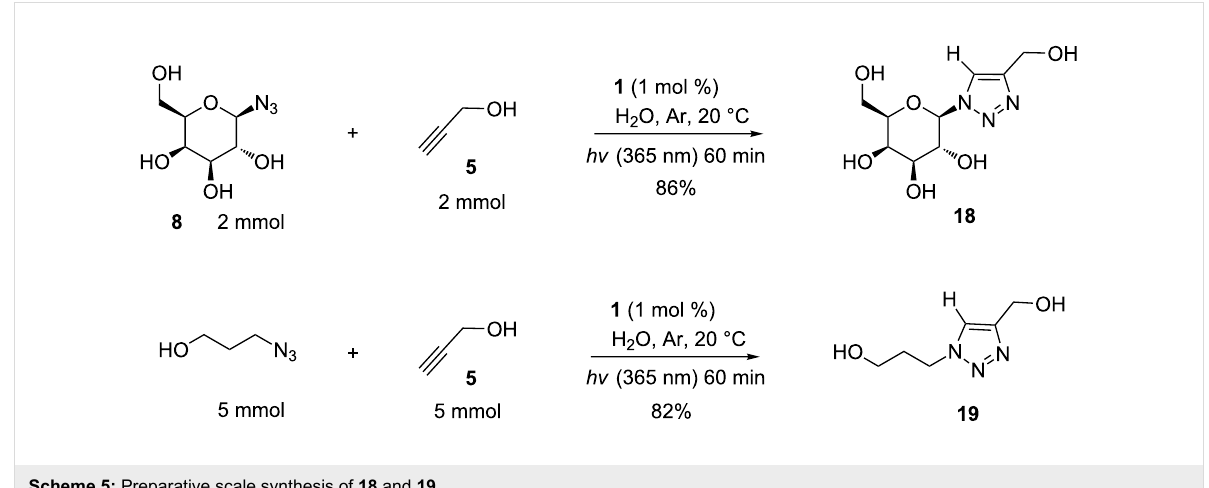
Scheme 5: Preparative scale synthesis of 18 and 19